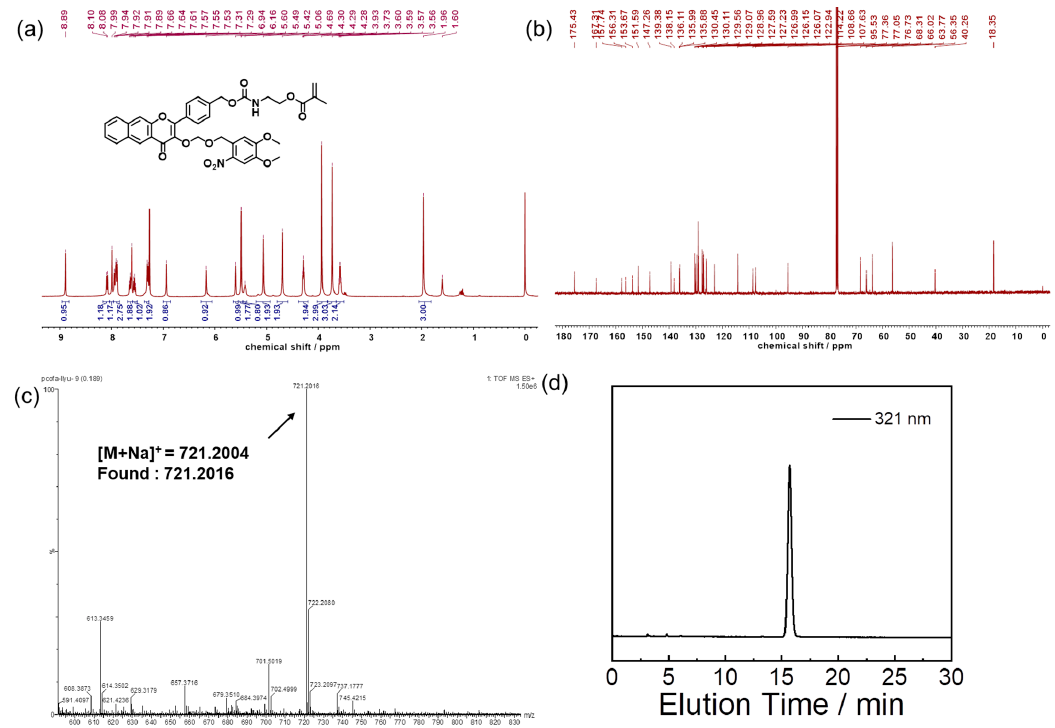
Figure 1. ( a ) 1 H and ( b ) 13 C NMR spectra recorded in CDCl 3 for FFM monomer; ( c ) ESI mass spectrum recorded for FFM monomer; ( d ) HPLC profile recorded at 321 nm for FFM monomer (0.125 mM; CH 3 CN/H 2 O, v/v = 6/4 as the eluent).